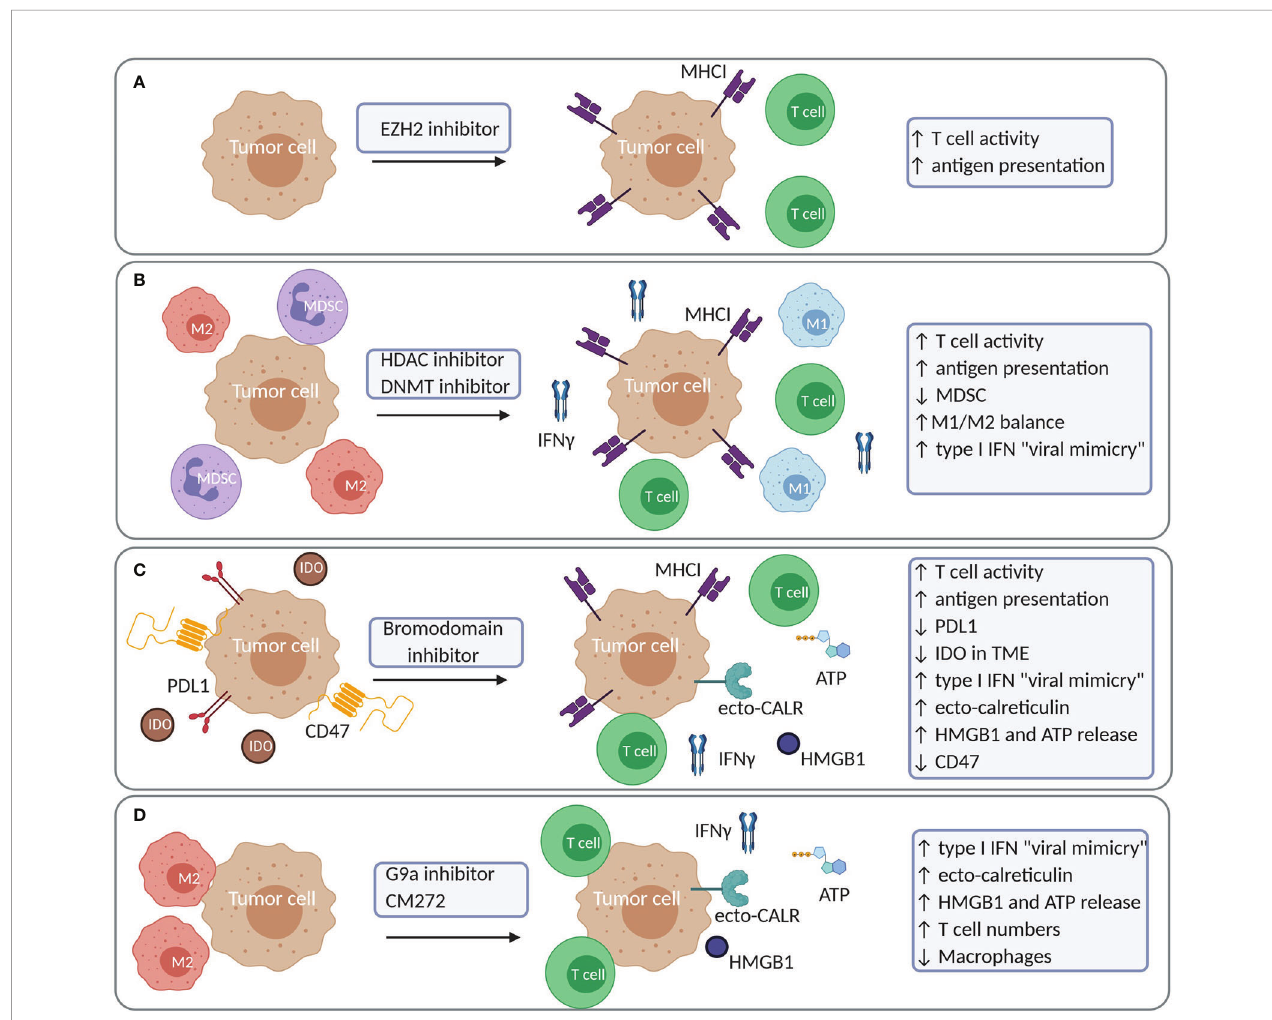
FIGURE 7 | Examples of increased tumor immunogenicity and modulation of the immune cell constitution in the TME upon treatment with epigenetic compounds. (A) EZH2 inhibition results in increased antigen presentation and T cell activity. (B) HDAC or DNMT inhibition increases antigen presentation and T cell activity while reducing MDSC and M2 macrophages. (C) Bromodomain inhibitors (JQ1) increase antigen presentation and T cell activity while it reduces tumoral PDL1 expression and IDO in the TME. JQ1 also induces a more complete picture of ICD with a type I IFN response, ecto-calreticulin, HMGB1 and ATP release. JQ1 moreover reduces CD47 expression in tumor cells (D) G9a inhibitors and CM-272 induce a type I IFN response due to viral mimicry in tumor cells. CM-272 induces a more complete picture of ICD with a type I IFN response, ecto-calreticulin, HMGB1 and ATP release. IDO, Indoleamine